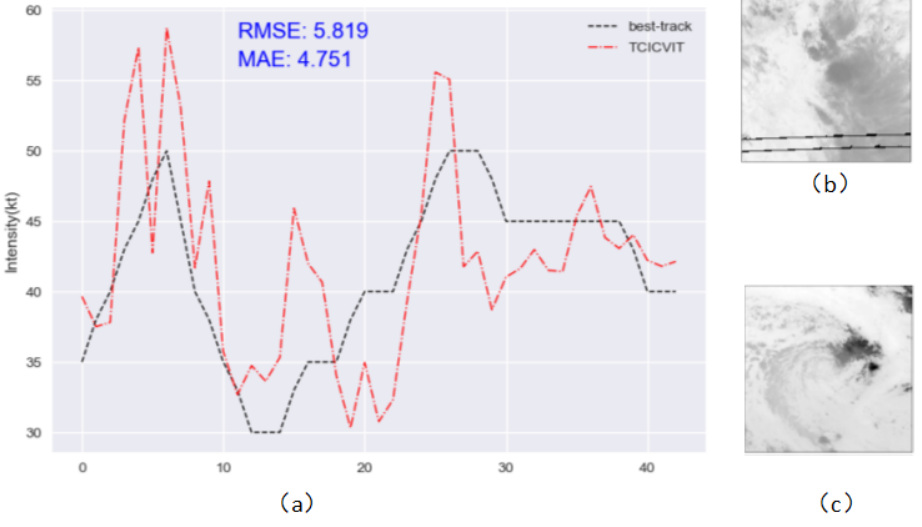
Figure 9. ( a ) Evolution of TC 201506S’s estimated and best-track intensity; ( b ) satellite cloud image at 2015011603; and ( c ) satellite cloud image at 2015011609.